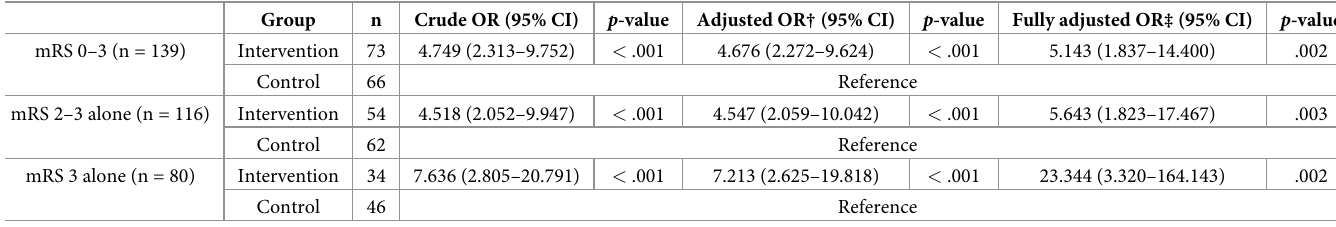
Table 2. The odds ratio of intervention for physical activity at 3